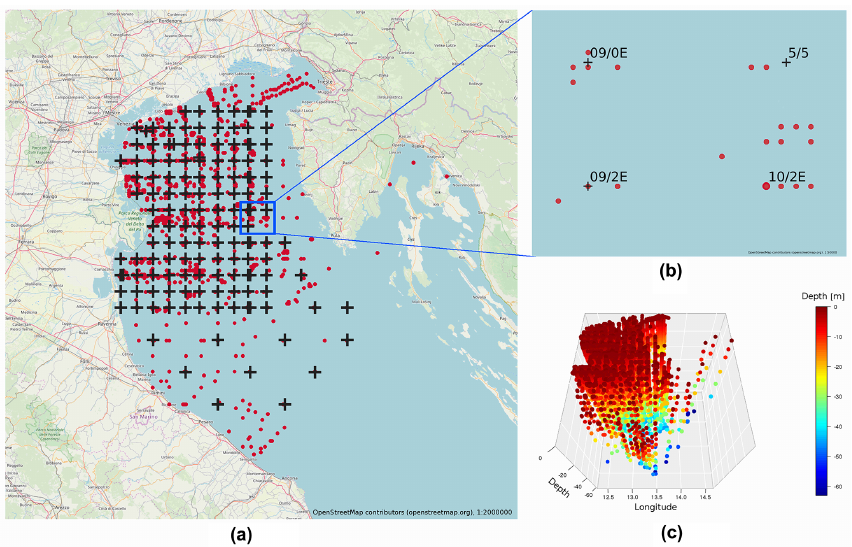
Figure 3. (a) Geographical distribution of the observations: red dots for observations and black crosses for nodes of the grid. (b) Example of cloud distribution of observations around sampling station 09/2E and the naming of new sampling station 10/2E. (c) A 3-D view of the database. Base map credits: © OpenStreetMap contributors 2019. Distributed under a CC-BY-SA